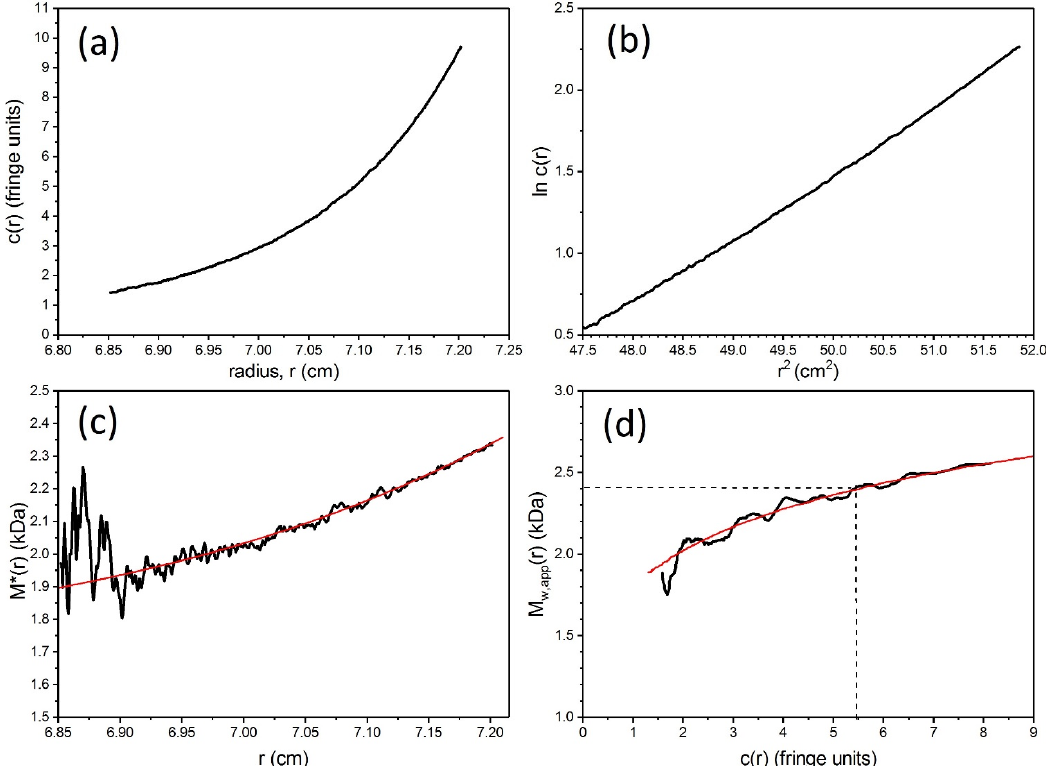
Figure 5. Sedimentation equilibrium analysis using SEDFIT-MSTAR for vancomycin. Solvent 0.9% NaCl at 7.0 °C, at a loading concentration c of ~1.25 mg/mL. ( a ) Concentration distribution c ( r ) (expressed in terms Rayleigh interference displacement units in a 12 mm optical path length cell) versus the radial displacement r at a given position in the cell ( b ) corresponding plot of lnc( r ) vs. r 2 . Departure from linearity is consistent with self-associative behaviour. ( c ) extrapolation of the M * integral function to the cell base to yield the whole distribution weight average molecular mass M w,app = (2.4 ± 0.1) kDa ( d ) plot of the local or point average molecular mass M w,app ( r ) as a function of local concentration c ( r ) in the ultracentrifuge cell obtained by taking a derivative of the data from plot ( b ). The dashed line gives the value of M w,app ( r ) at the “hinge point”, i.e., at the value of c ( r ) which equals the loading concentration. This also = M w,app , the (apparent) weight average molecular mass for the whole distribution and gives a check on the value obtained from ( c ). For other solvent conditions see [4]. Adapted from Phillips-Jones et al. [4] and reproduced by permission from the Nature Publishing Group.